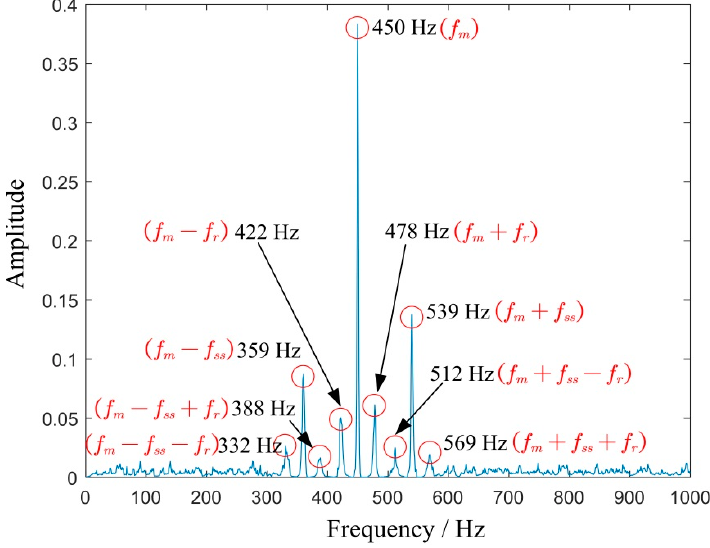
Figure 8. 2D energy-frequency map by proposed method.